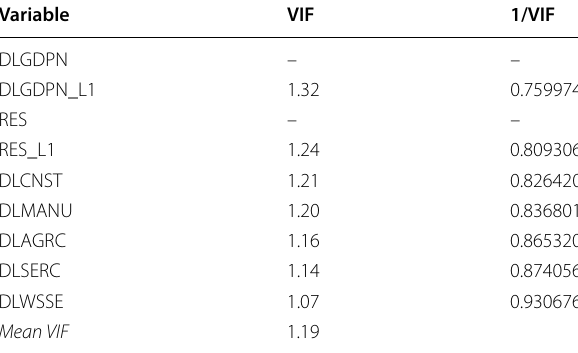
Table 8 Multicollinearity test results